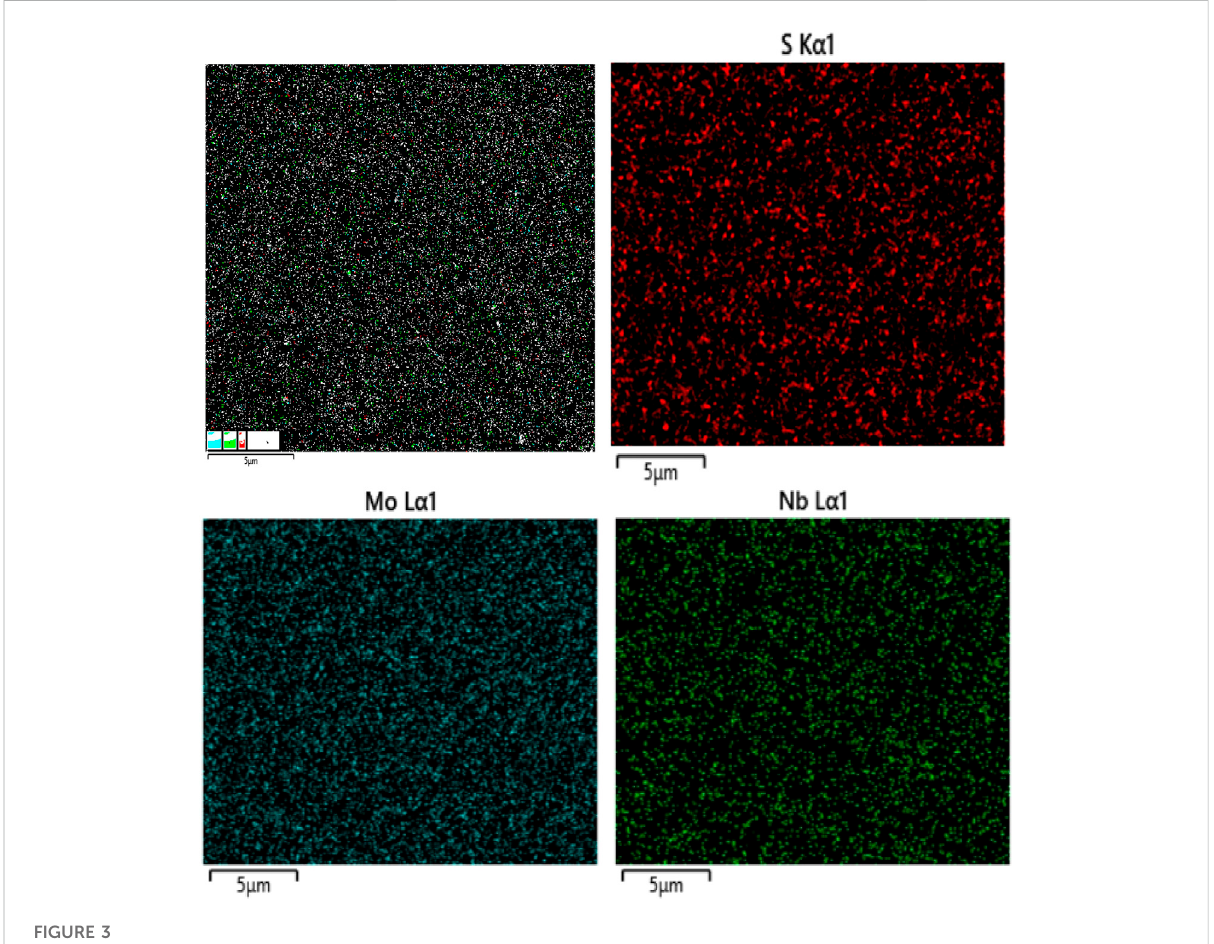
FIGURE 3 EDS elemental mapping.